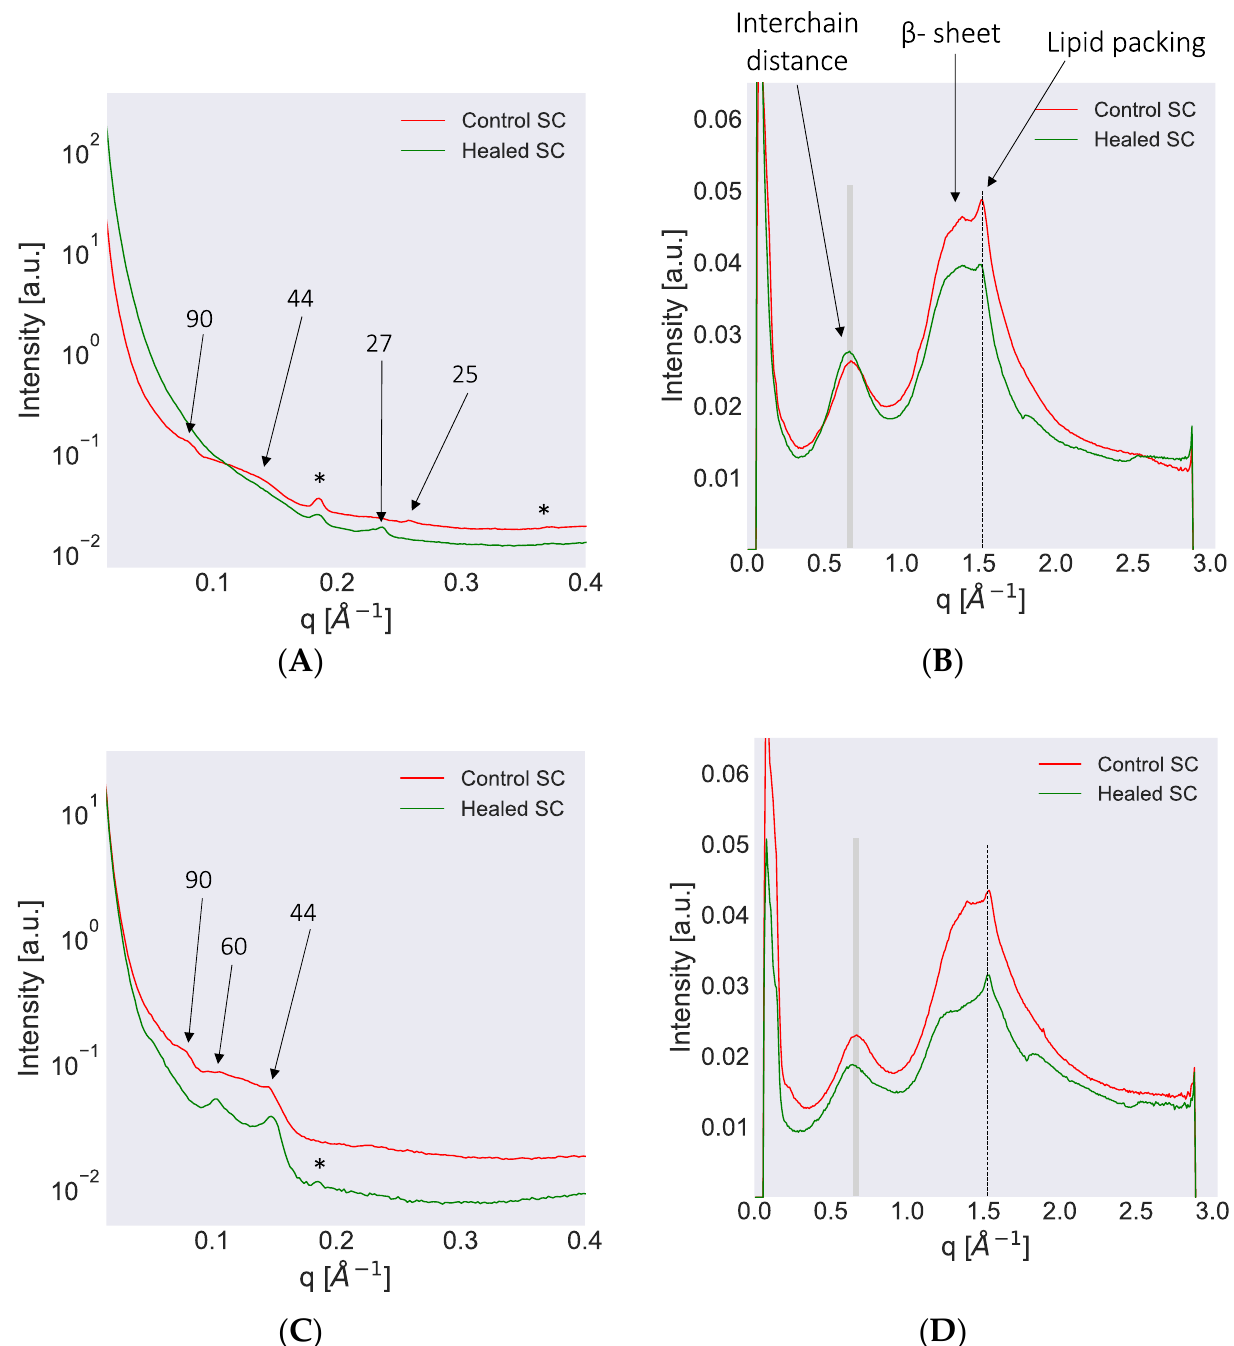
Figure 5. Small and wide-angle X-ray diffraction (SWAXD) spectra of control and healed stratum corneum (SC) excised from pig 1 and recorded at dry ( A , B ) and wet (97% RH) conditions ( C , D ). The SAXD spectra are provided on the left column whereas the WAXD spectra are on the right. In the SAXD region, several peaks attributed to lipid lamellar ordering and keratin packing are identified. The numbers with arrows indicate the d -spacing in Å for various peaks. Phase-separated crystalline Chol was also detected in some spectra and then indicated by an asterisk (*) sign. In the WAXD region, the shaded lines indicate peaks originating from the keratin interchain distance and show a change in peak position following hydration of the sample. The lipid acyl chain ordering indicated by dotted lines do not show a shift in peak position when comparing dry and hydrated conditions. The secondary β-sheet structure of keratin could also be detected and is marked in the plot. All SWAXD measurements were performed at 32 °C, which represents average physiological skin temperature.